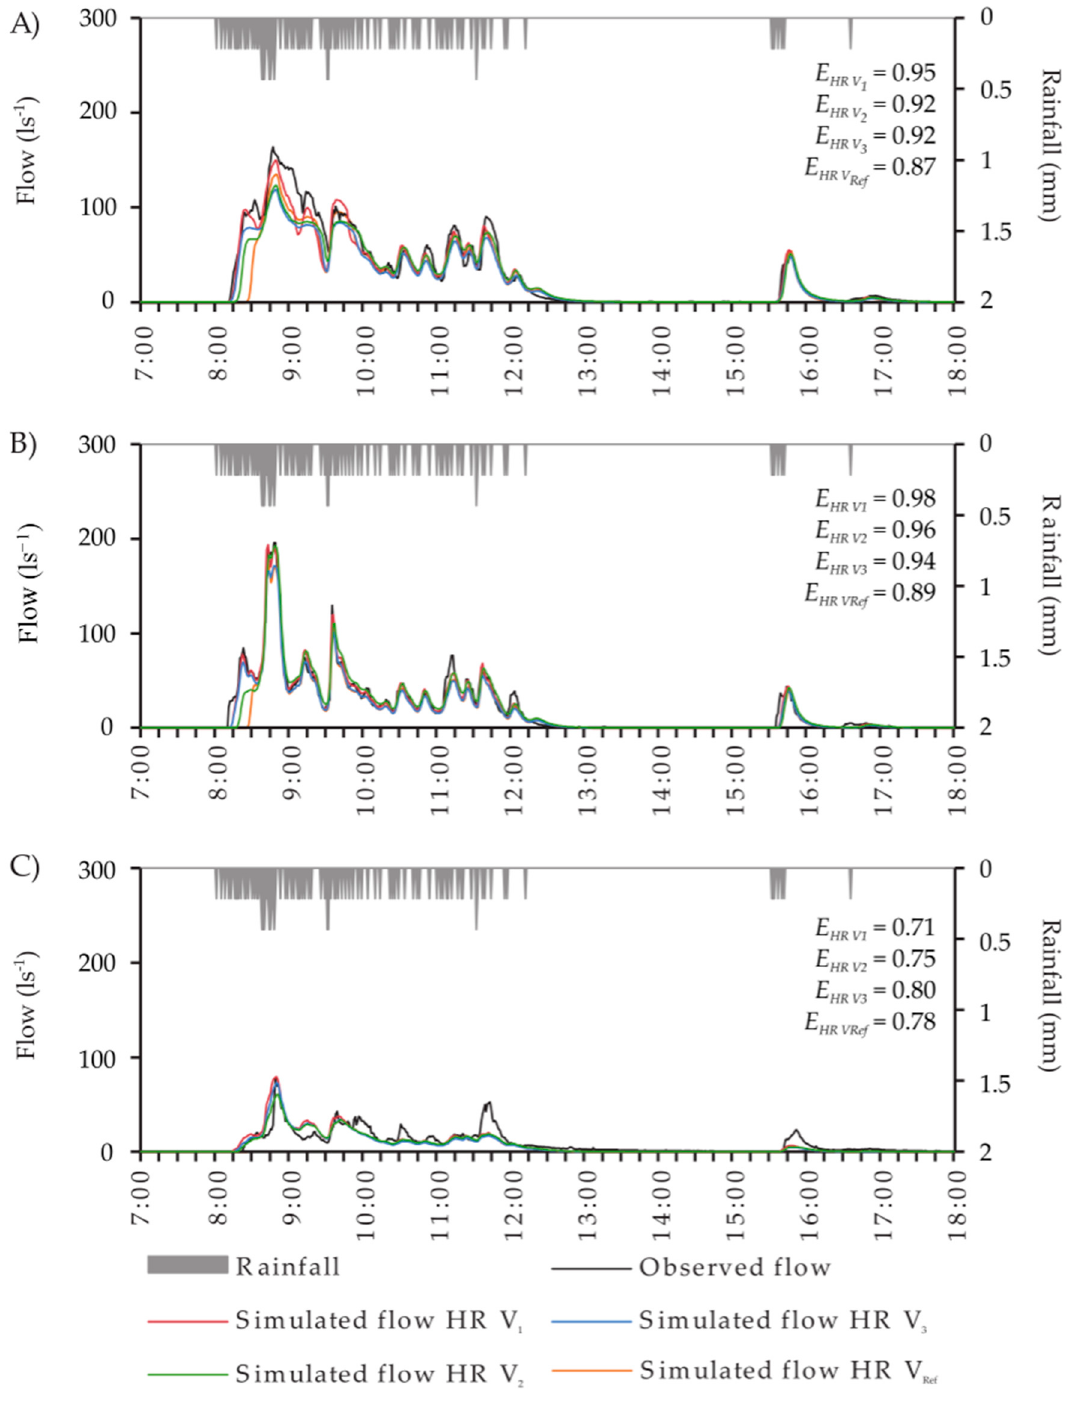
Figure 4. Observed and simulated (HR) flow for ( A ) Catchment 1; ( B ) Catchment 2; and ( C ) Catchment 3, and the model efficiency E for the parameter sets V 1 , V 2 , V 3, and V Ref (event rainfall depth 22.0 mm, peak intensity 1.73 mm/5 min).